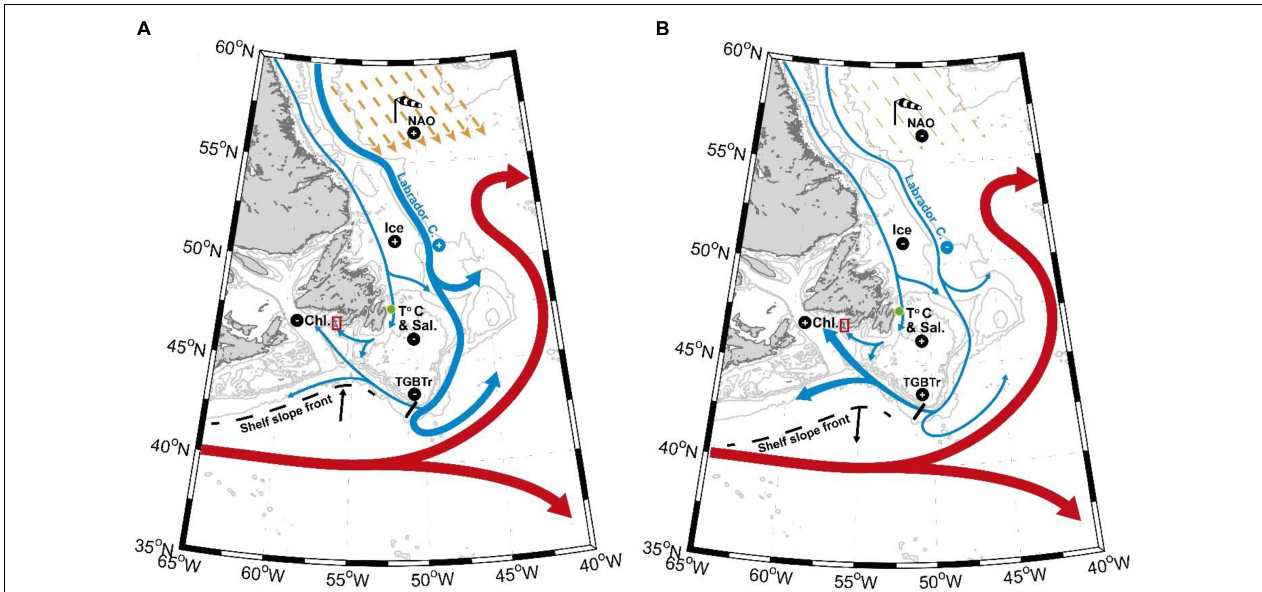
FIGURE 8 | Maps illustrating the environmental scenarios associated with negative (A) and positive (B) growth anomalies of A. islandica at SPM. Yellow arrows in the Labrador Sea represent north westerly winds (black and white windsock) related to NAO positive (A) or negative (B) phases. The main acronyms corresponding to environmental datasets names are as follow: NAO – North Atlantic Oscillation; Ice – Sea ice cover over the Newfoundland shelf; T ◦ C and Sal. – Station 27 temperature and salinity; TGBTr – Tail of the Grand Banks westward transport; Chl. – Mean local chlorophyll a concentration from April to